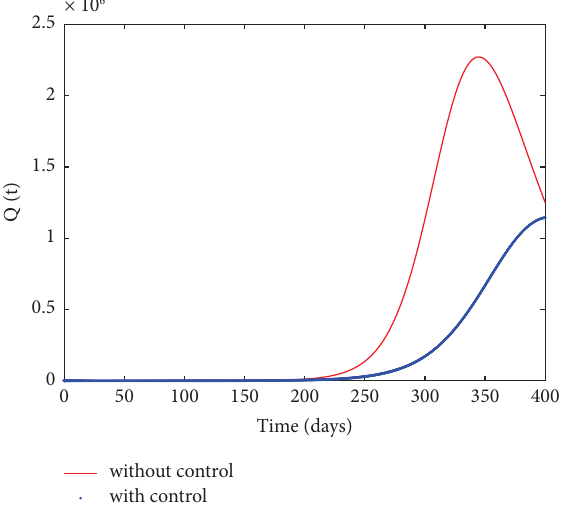
Figure 20: Behaviour of the quarantine individuals with and without the vaccination control.